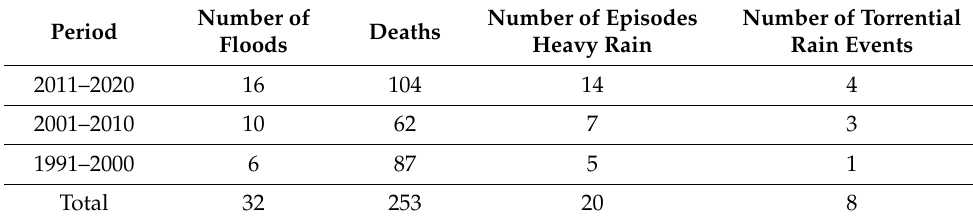
Table 1. Deaths caused by floods in 1991-2020 in the French Mediterranean area. Source: